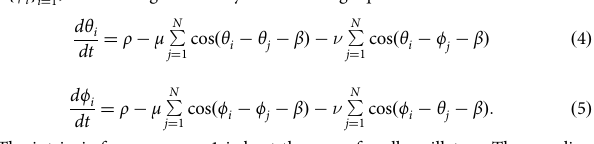
Fig. 5 Recurrent Neural Network features. A Network supervisor. B Fast Fourier Transform (FFT) of the network supervisor. Each FFT is normalized to the highest peak and plotted in a log y-scale. The three dashed vertical lines indicate the three highest frequencies ( f 1 = 0.021, f 2 = 0.059 and f = 0.096), which correspond to the frequency of the synchronized ( f 3 and to the frequencies of the unsynchronized groups ( f 1 , f 2 and f 3 ). C Network output. D FFT of the network output. E Principal component analysis (PCA) of the network's fi ring rates. We plot the 1rst, the 3rd and the 5th components vs time (dark red, turquoise and yellow or black, dark and light gray for b/w printing). F FFTs (dark red, turquoise and yellow or black, dark and light gray for b/w printing) of the 1rst, 2nd and 3rd components, respectively. G Individual fi ring rates vs time. H FFTs of the individual fi ring rates. I Mean of the fi ring rates vs time. J FFT of the mean of the fi ring